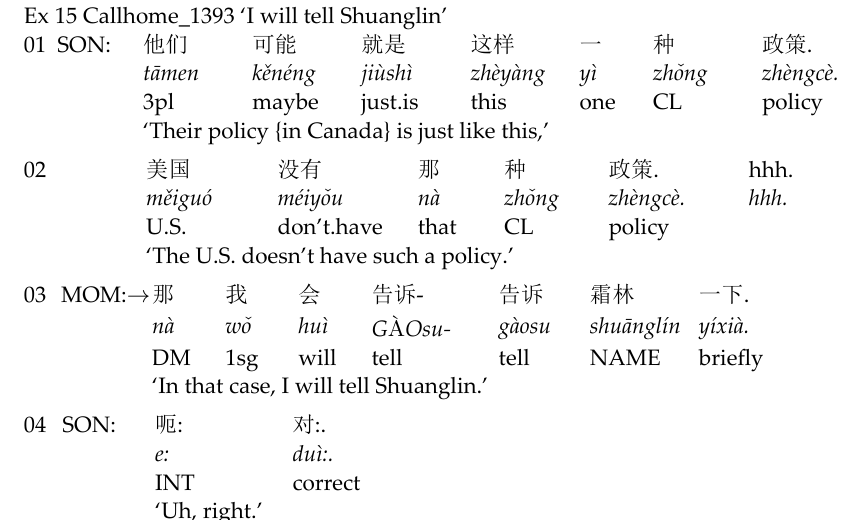
Figure 6. Waveform, spectrogram, pitch contour, and intensity of line 06 in In. In Ex 15, the speaker offers to benefit a third-party using the [ w ǒ huì X ( de )] format with an unstressed huì . The two speakers, mom (MOM) and son (SON), have just discussed a relative’s plan to immigrate to a foreign country. It is indicated in the earlier part of the phone call that the mom contacted this relative, Shuanglin, frequently, and she is the one who launches this topic. The son, who lives in the U.S., is more knowledgeable about the immigration process and starts providing information and suggestions. In line 03, MOM reports her plan to tell the relative (the son’s cousin) this information, ‘I will tell Shuanglin.’ The promise shows that MOM treats informing the relative of this important information as a responsibility of hers, and this understanding is shared by the son as he responds “uh right’ in line 04, followed by another piece of advice for the cousin. In other words, the two speakers have established a common ground that the information will be delivered to the relative by the mom after the call, and the mom’s promise confirms this expected commitment.